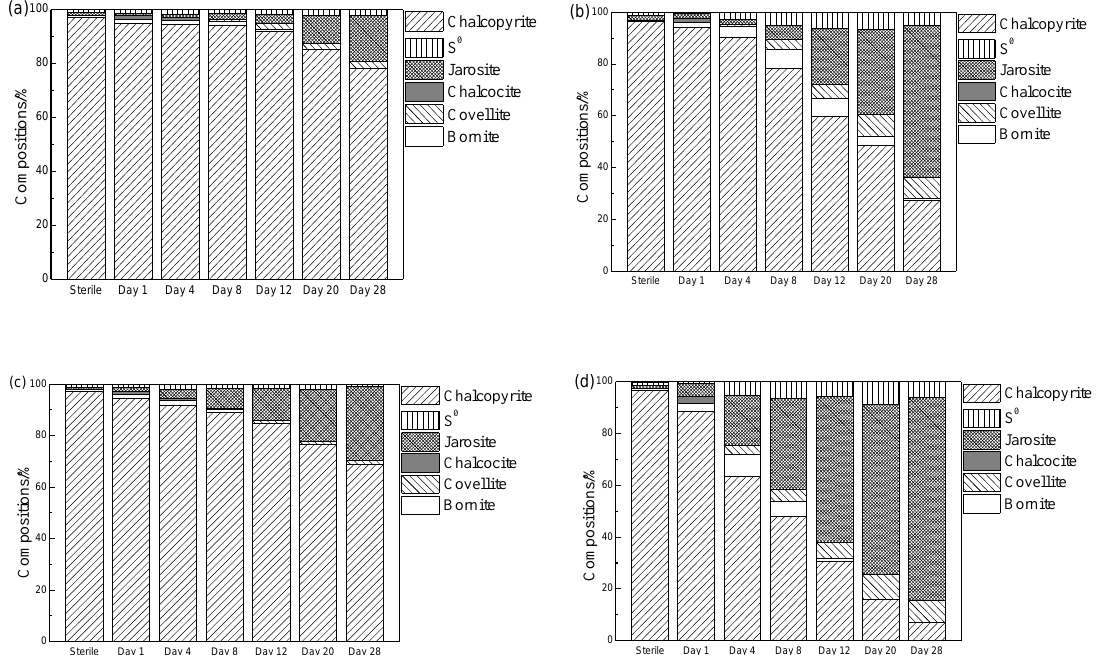
Figure 8. Sulfur speciation compositions during chalcopyrite bioleaching by mesophilic culture and in the sterile control at 30 ◦ C without Ag + ( a ) and with 0.3% of Ag + ( b ), and the compositions during chalcopyrite bioleaching by thermophilic culture and in the sterile control at 48 ◦ C without Ag + ( c ) and with 0.3% of Ag + ( d ), by the LC fitting of the unknown spectra from Figure 7b–e with the reference spectra from Figure 7a.